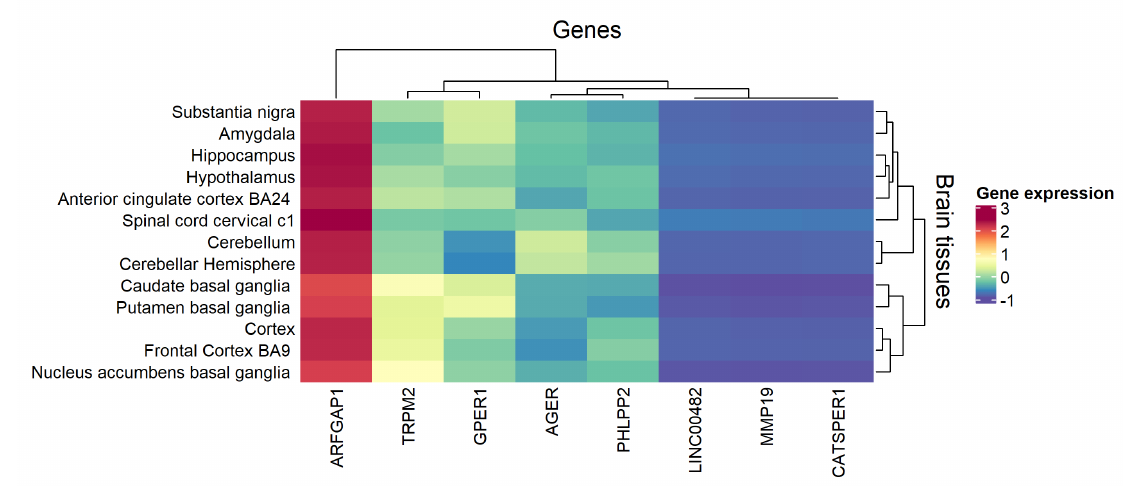
Figure 3. Heatmap of median gene expression for DE genes in brain tissues. Data were available in GTEx portal